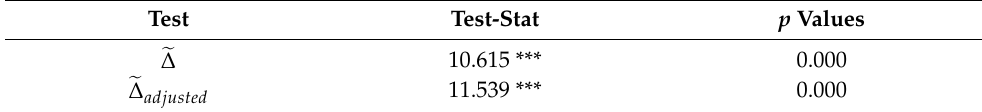
Table 5. Slope of homogeneity test